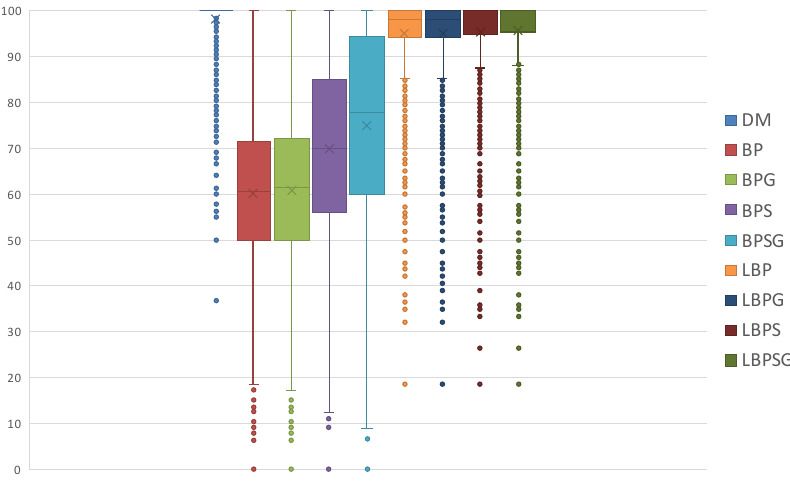
Figure 12. BP and LBP variants: LO jobs scheduled per task set in HC-HP